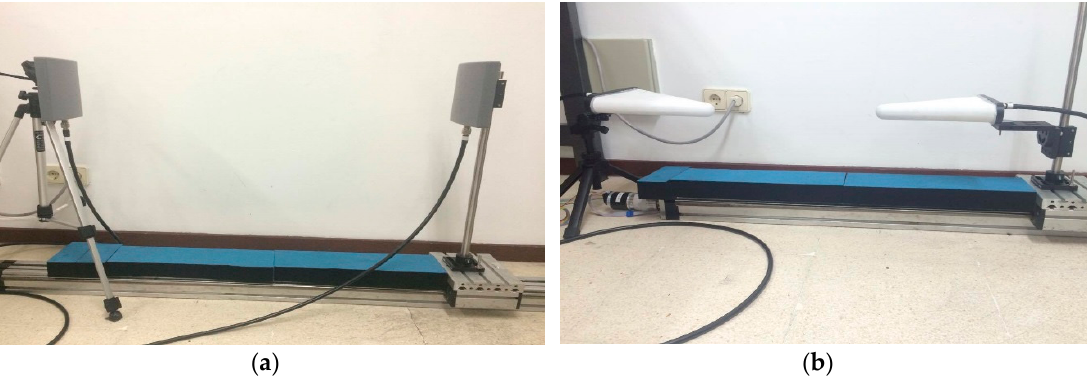
Figure 1. Path loss measurement system: ( a ) 868 MHz antenna setup; ( b ) 2.4/5.8 GHz antenna setup.